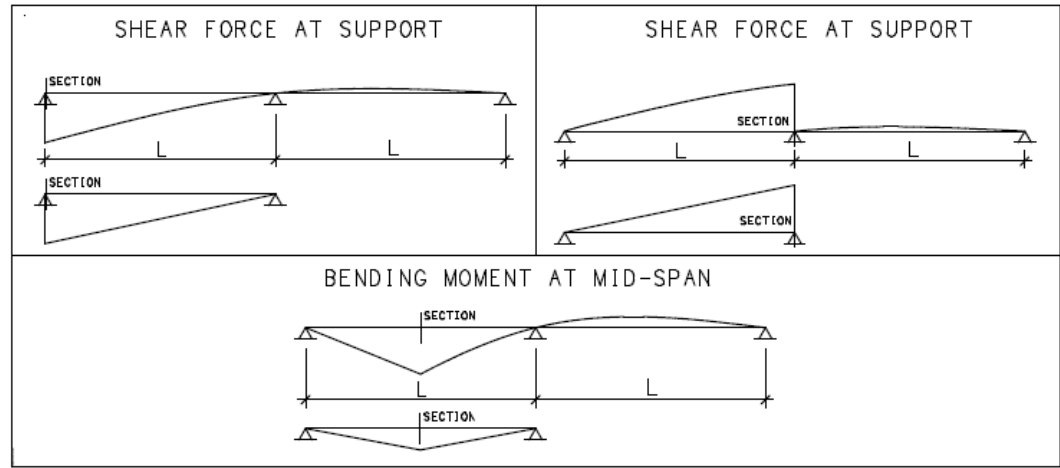
Figure 12. Similar influence